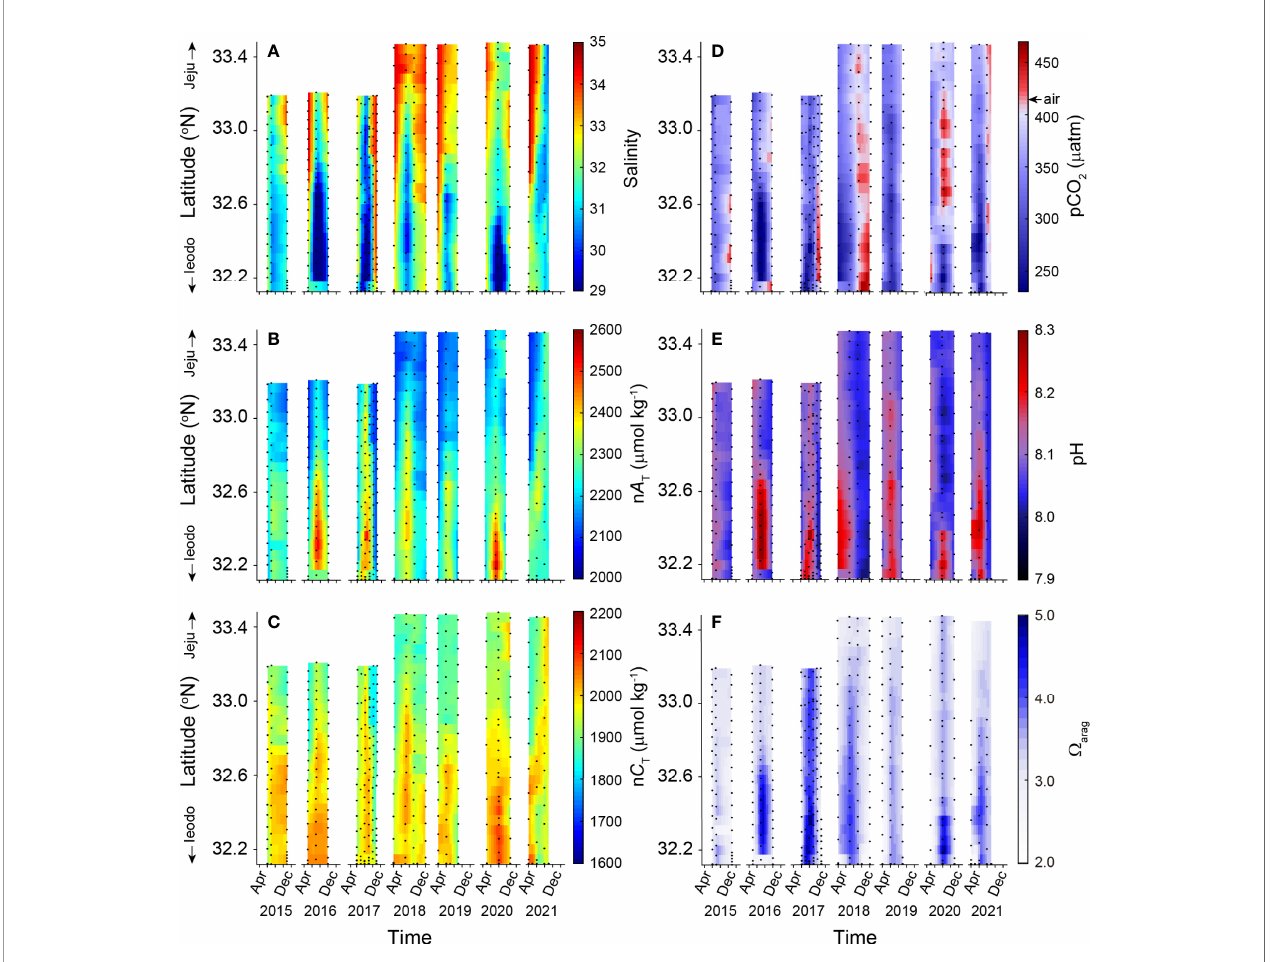
FIGURE 3 | Meridional distributions of (A) salinity, (B) salinity-normalized A T (n A T ), (C) salinity-normalized C T (n C T ), (D) seawater pCO 2 , (E) pH, and (F) aragonite saturation state ( W arag ). Longitudes covary along the survey line (125.17 – 126.55°E) between Ieodo and Jeju Island. The lower the latitude, the closer to